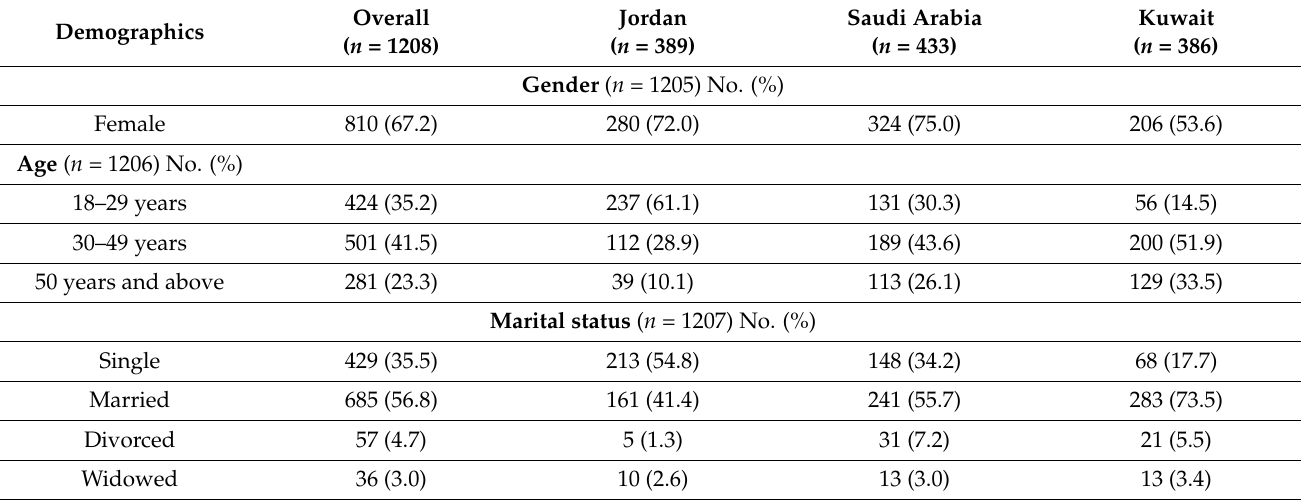
Table 1. Participants’ characteristics from each